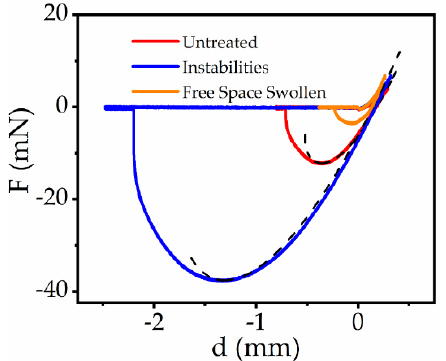
Figure A1. Adhesion tests performed with a 6 mm steel spherical probe. The red, orange, and blue curves represent the force – displacement curves measured for the untreated samples, the free swollen samples, and the samples with instabilities, respectively.